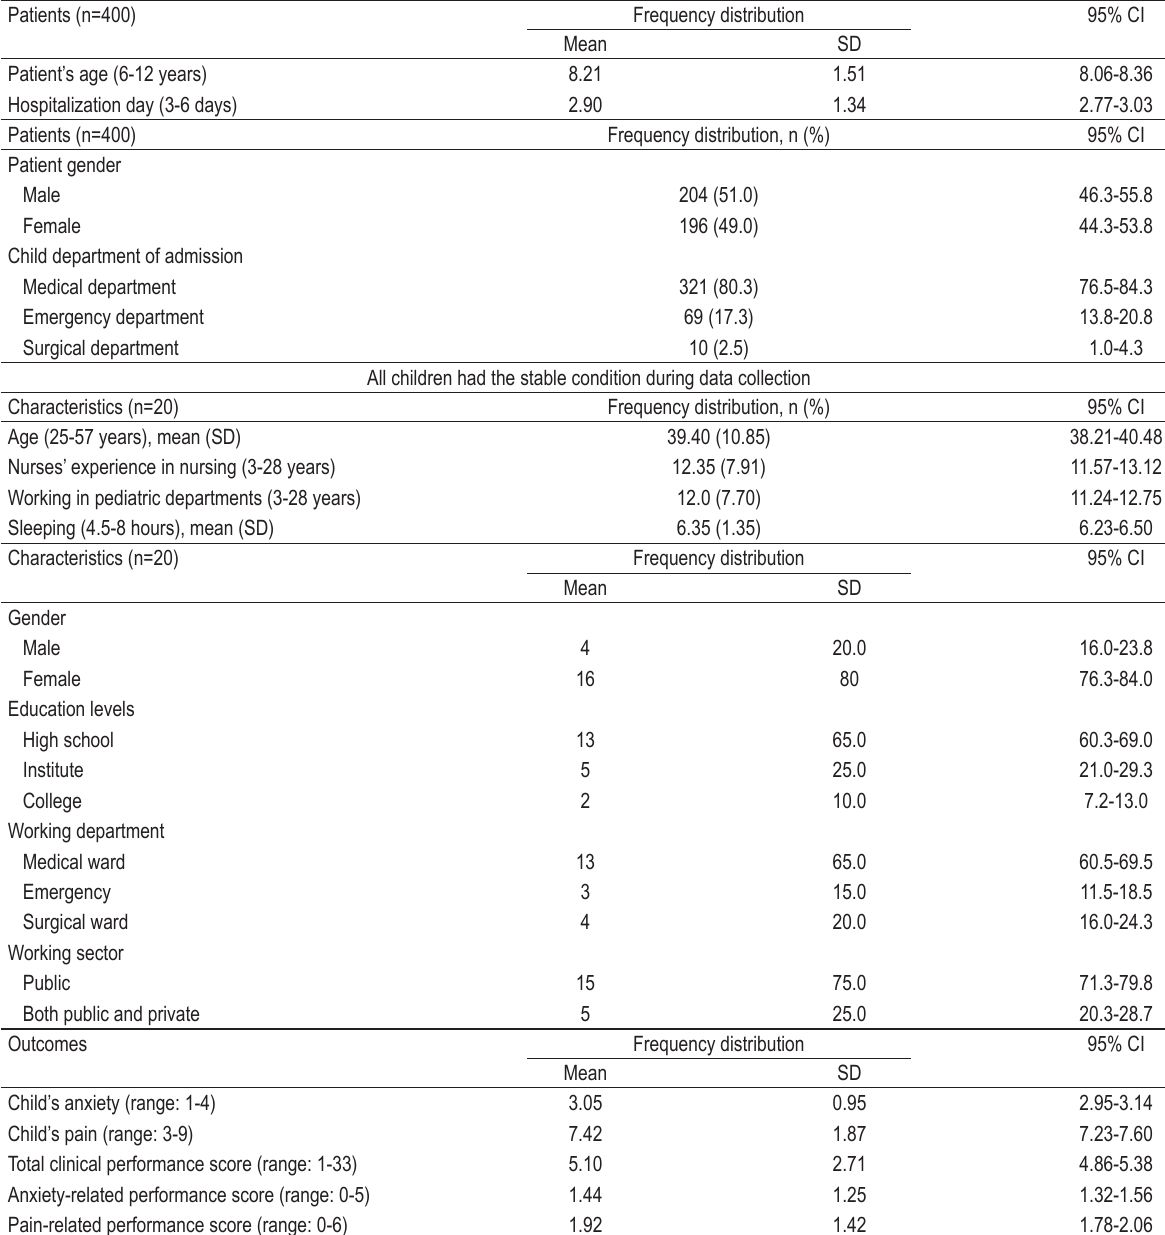
TABLE 1. General characteristics of patients, nurses, and their outcomes Patients